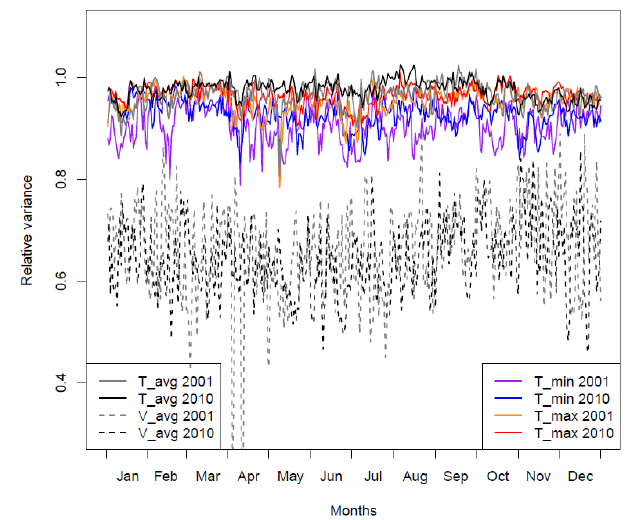
Figure 19. Time series of the ratio of spatial variance of interpo- lated vs. observed station data for the years 2001 and 2010 based on cross validation. The color code indicates the parameters and